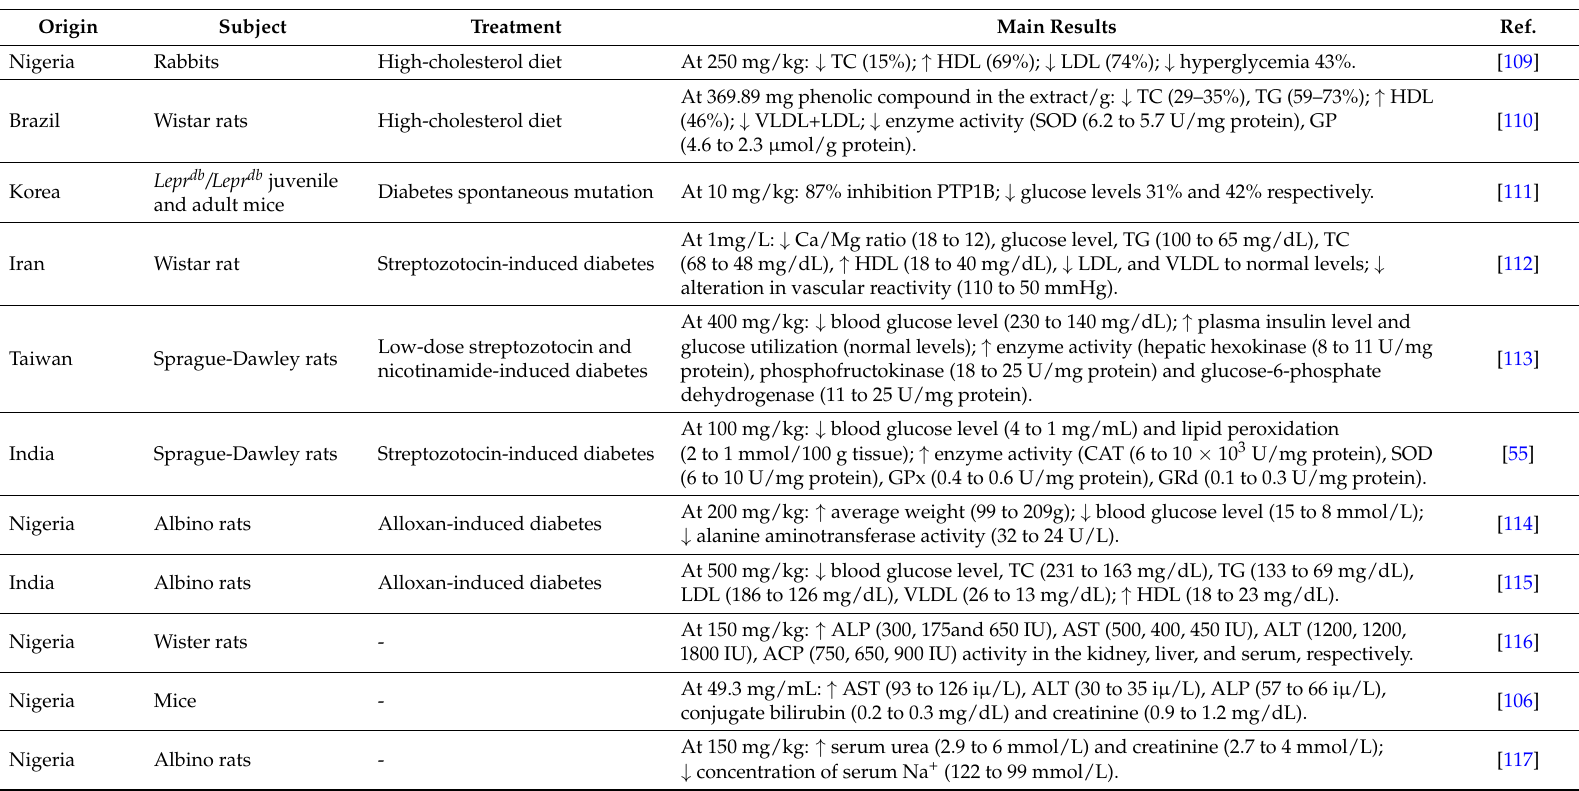
Table 8. Endocrine and metabolic in vivo assays with guava